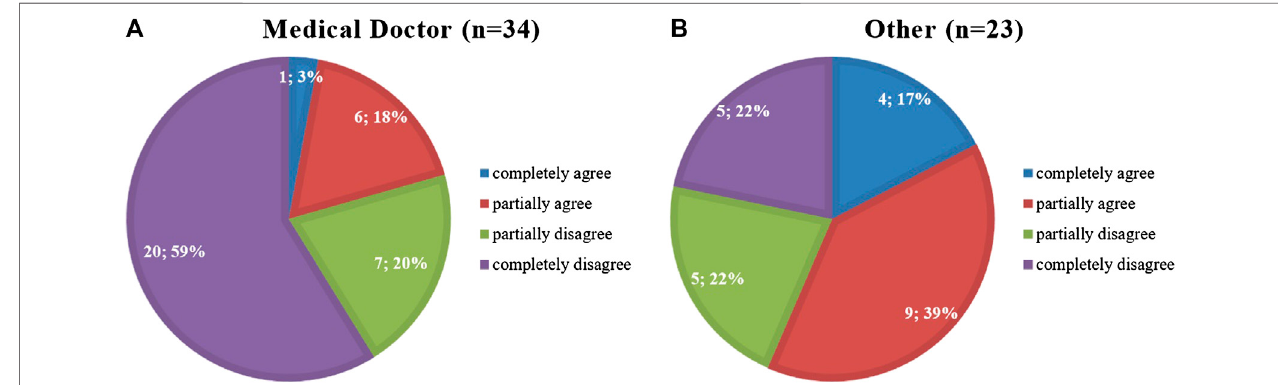
FIGURE3| ResultsofQ6.Howmuchdoyouagreewiththefollowingstatement: “ AIismoredangerousthannuclearweapons ” (Musk,2018)fortheprofessionsof (A) “ Medical Doctor ” and (B) “ Other. ”